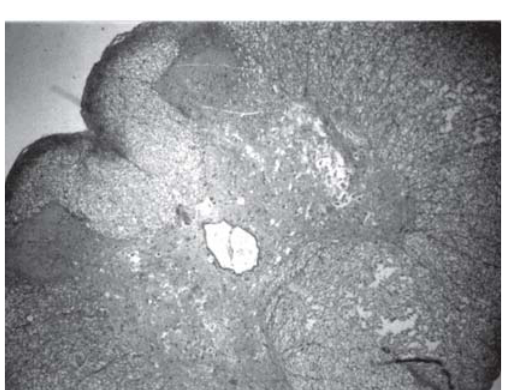
Fig. 2 - Sections from spinal cords of animals in the sham operations